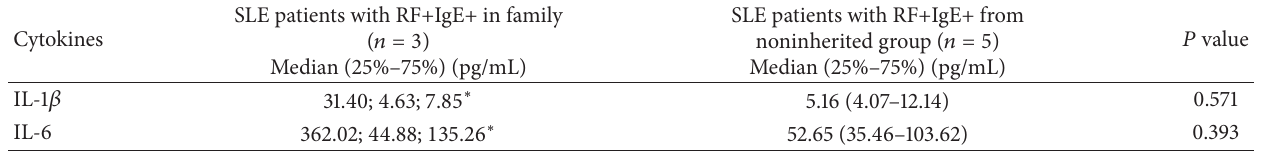
Table 6: Serum cytokine levels of SLE patients with RF+IgE+ in family and in noninherited group. SLE patients with RF+IgE+ in family Cytokines